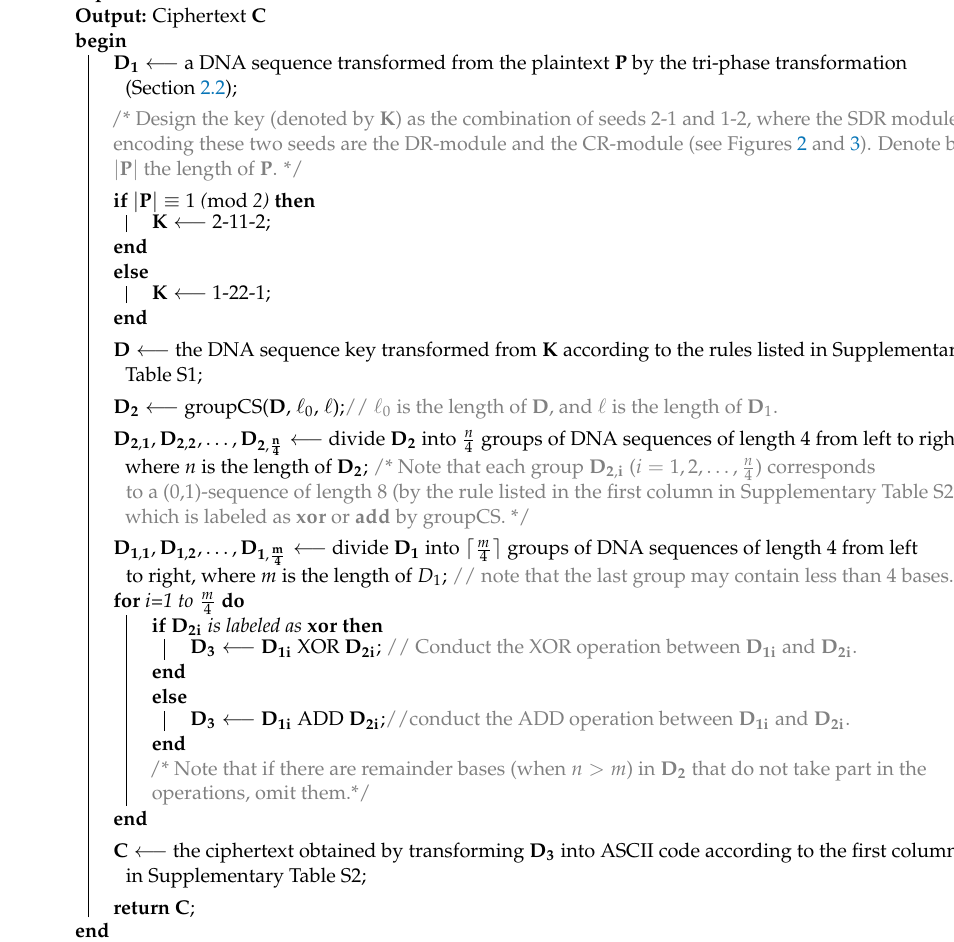
Algorithm 3: BioEN (a DNA-strand-displacement-based encryption